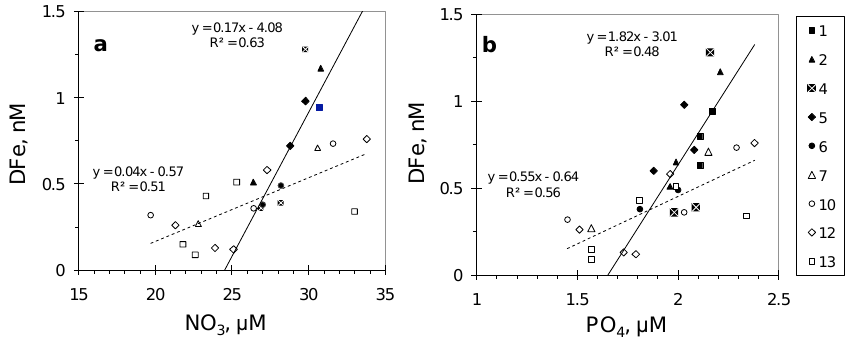
Fig. 9. Relationships between DFe and macronutrients at the nine stations where nutrient concentrations were determined. (a) DFe versus NO 3 , (b) DFe vs. PO 4 . Data from Drake Passage stations (#10, 12, 13) and station 7 are shown as open symbols and data from Bransfield Strait stations (#1–2, 4–6) are shown with closed symbols. Linear regressions, with equations, are shown for both zones. Station numbers are shown in the column to the